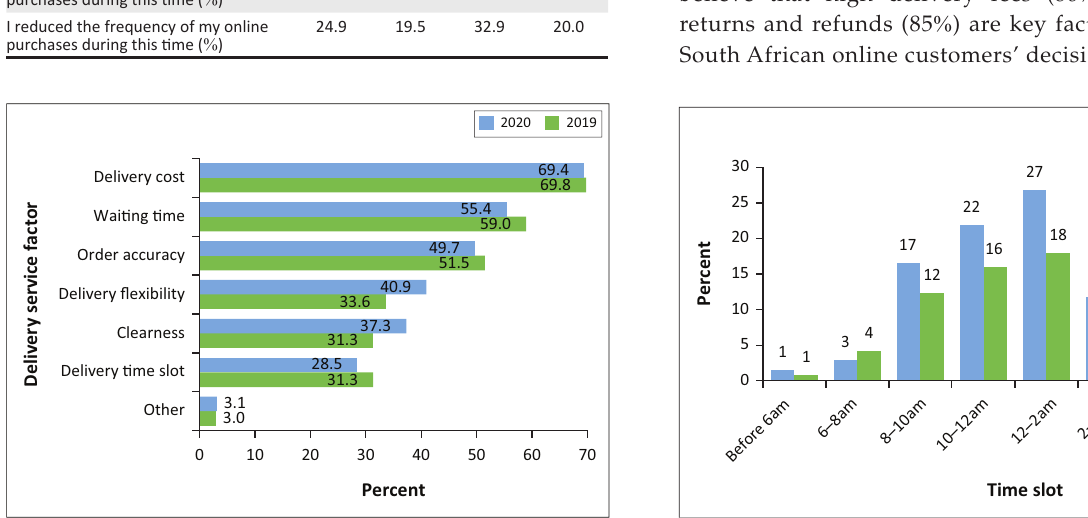
FIGURE 2: Important delivery service factors. FIGURE 3: Preferred delivery time slot.